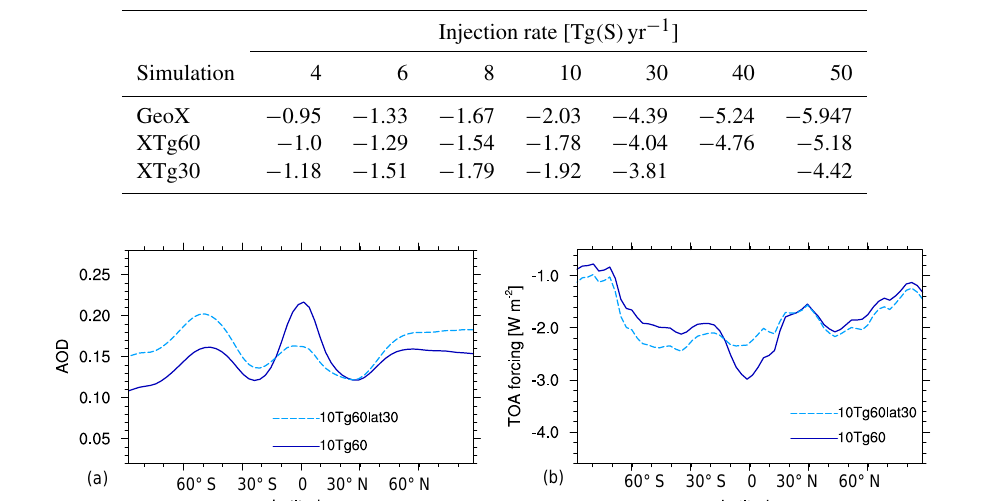
Table 2. Top of the atmosphere radiative forcing [Wm − 2 ], calculated using double radiative transfer calculations, for simulations with a 39-layer version of the model and injection height at 60hPa (GeoX) and two 90-layer model simulations with injection height at 60hPa (XTg60) and 30hPa (XTg30).